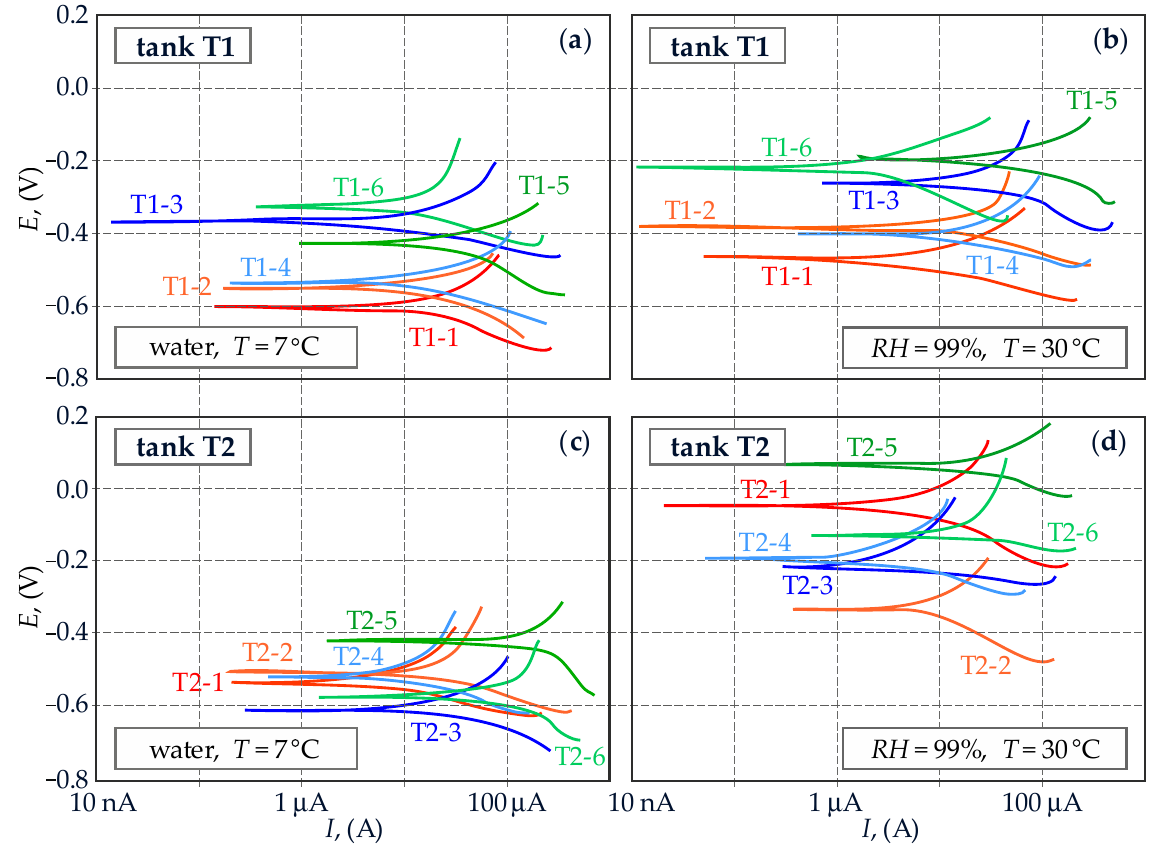
Figure 6. Polarization curves obtained from the method linear polarization resistance (LPR) con- ducted on cylindrical concrete cores with embedded fragments of steel rebars drilled from reinforced concrete structures of tanks for fresh water: ( a ) results for the tank T1—tests in water at tempera- ture T = 7 ◦ C; ( b ) results for the tank T1—tests at air temperature T = 30 ◦ C and relative humidity RH = 99%; ( c ) results for the tank T2—tests in water at temperature T = 7 ◦ C; and ( d ) results for the tank T2—tests at air temperature T = 30 ◦ C and relative humidity RH = 99%.